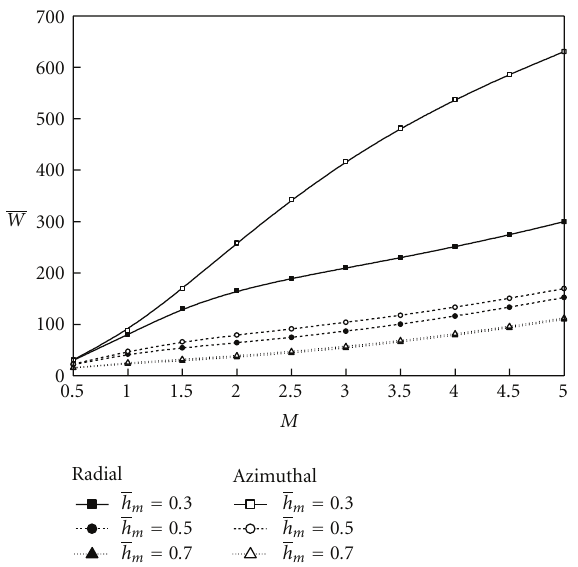
Figure 6: Variation of nondimensional mean load-carrying capac- ity W with M for di ff erent values of h m with β = 0 . 05, l = 0 . 3, c = 0 . 3, and ψ = 0 . 01.